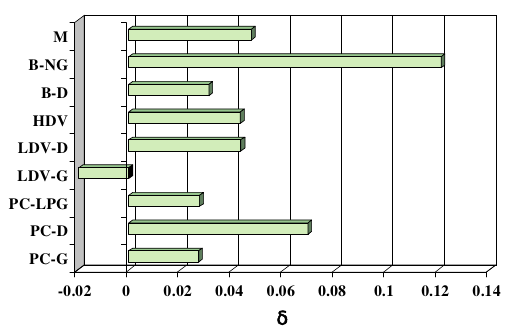
Fig. 2. The relative difference of motor vehicles number in Poland in 2016 year versus 2015 year